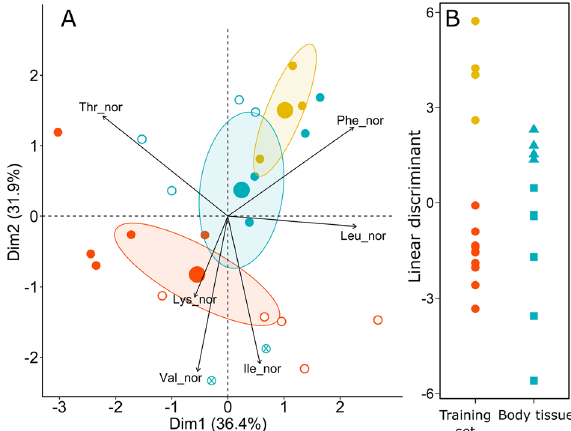
Figure 2. (A) Principal component analysis (PCA) using normalized δ 13 C values of essential amino acids (δ 13 C EAA ) in surface sediments (yellow), gut contents (red) and body tissue (blue) of O. mutabilis (filled symbols), E. rostrata (open symbols), and body tissue of S. globosa (circled cross). Ellipses outline the 95% confidence region around the mean (large symbols) for each group. (B) Linear Discriminant Analysis (LDA) based on a training set built with δ 13 C EAA values of surface sediments (yellow) and gut contents (red). Body tissue samples (blue) were collected in the period of low food supply (i.e. May; squares) and in the period of high food supply (i.e. October; triangles).